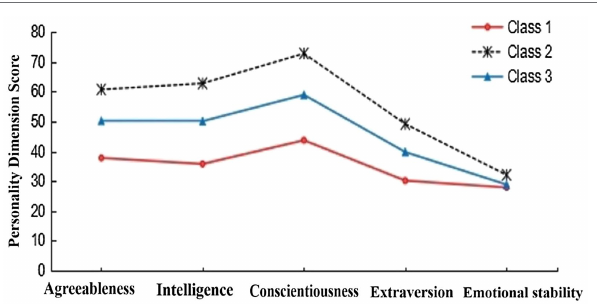
FIGURE 3 | Potential profile of the three-class model ( n 2 = 5,183).